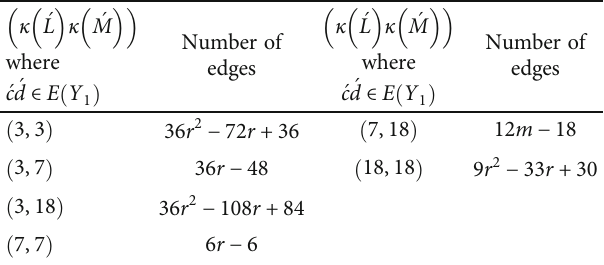
Table 1: Degree-based edge partition of HDN4 ð r Þ of the end vertices on each